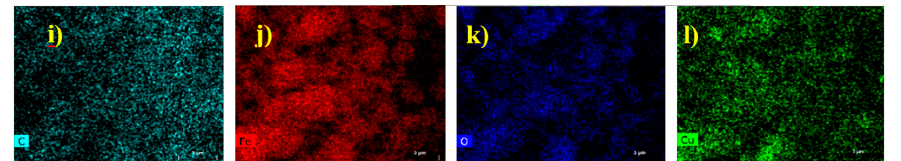
Figure 4. SEM mapping experiments on Fe 3 O 4 @EDTA ‐ Mn 2+ ( 1 ) MNPs: ( a ) raw micrograph; ( b ) overlap of the raw micrograph with Mn element detection; ( c ) C element detection; ( d ) Fe element detection; ( e ) O element detection; ( f ) Mn element detection. SEM mapping experiments on Fe 3 O 4 @EDTA ‐ Cu 2+